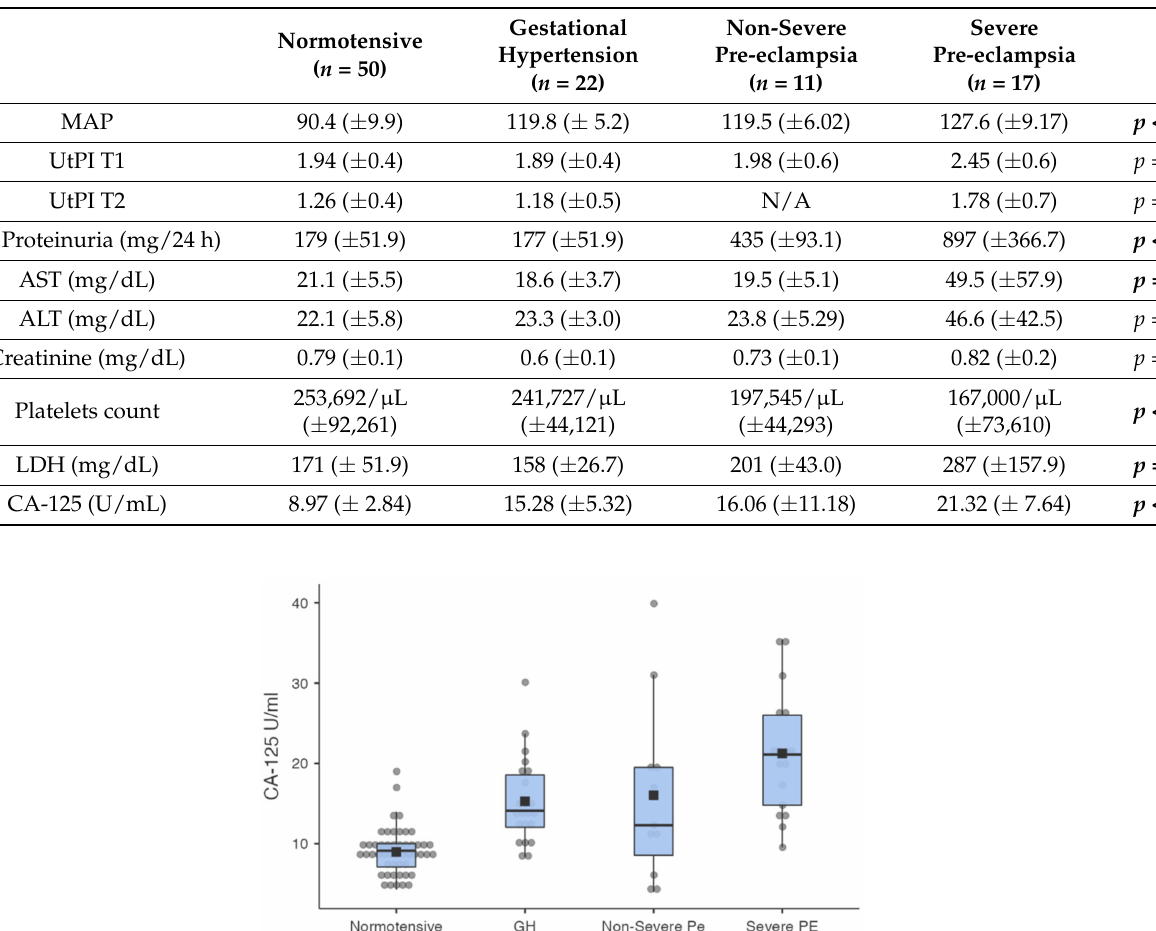
Table 2. Clinical and biological parameters of the study population.